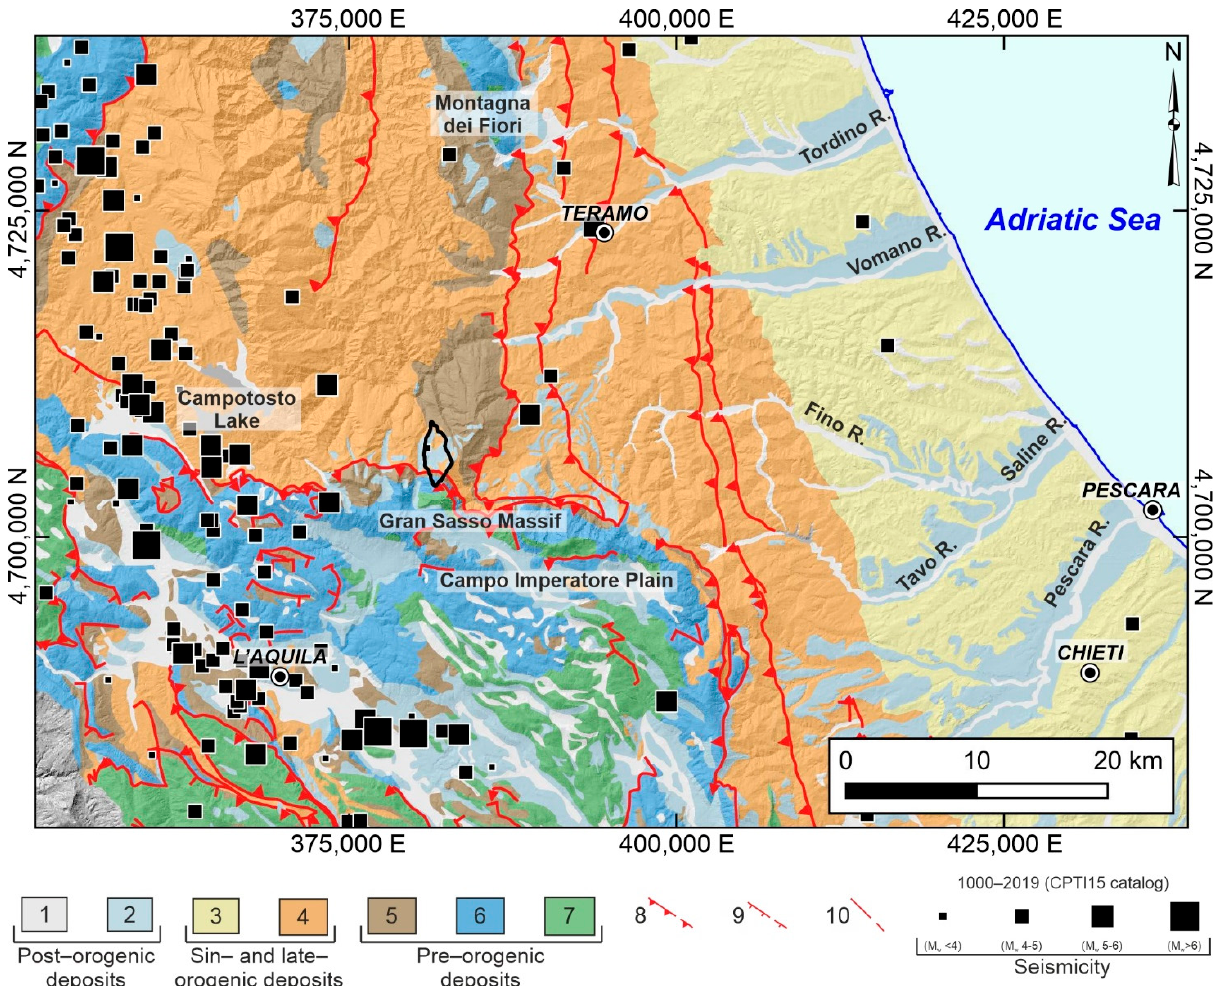
Figure 2. Geological map of NE Abruzzo (modified from [59]). Legend: post-orogenic deposits—(1) fluvial deposits (Holocene) and (2) fluvial and alluvial fan deposits (Middle-Late Pleistocene); sin- and late-orogenic deposits—(3) hemipelagic sequences with conglomerate levels (Late Pliocene–Early Pleistocene) and (4) turbiditic foredeep sequences (Late Miocene–Early Pliocene); pre-orogenic deposits—(5) carbonate ramp facies (Early Miocene-Early Pliocene), (6) slope and pelagic basin sequences (Cretaceous–Miocene), and (7) carbonate platform sequences (Jurassic–Miocene); (8) major thrust (dashed if buried); (9) major normal fault (dashed if buried); and (10) major fault with strike-slip or reverse component (dashed if buried). Seismicity derived from the CPTI15 catalog [60]. The black line indicates the location of the study area.